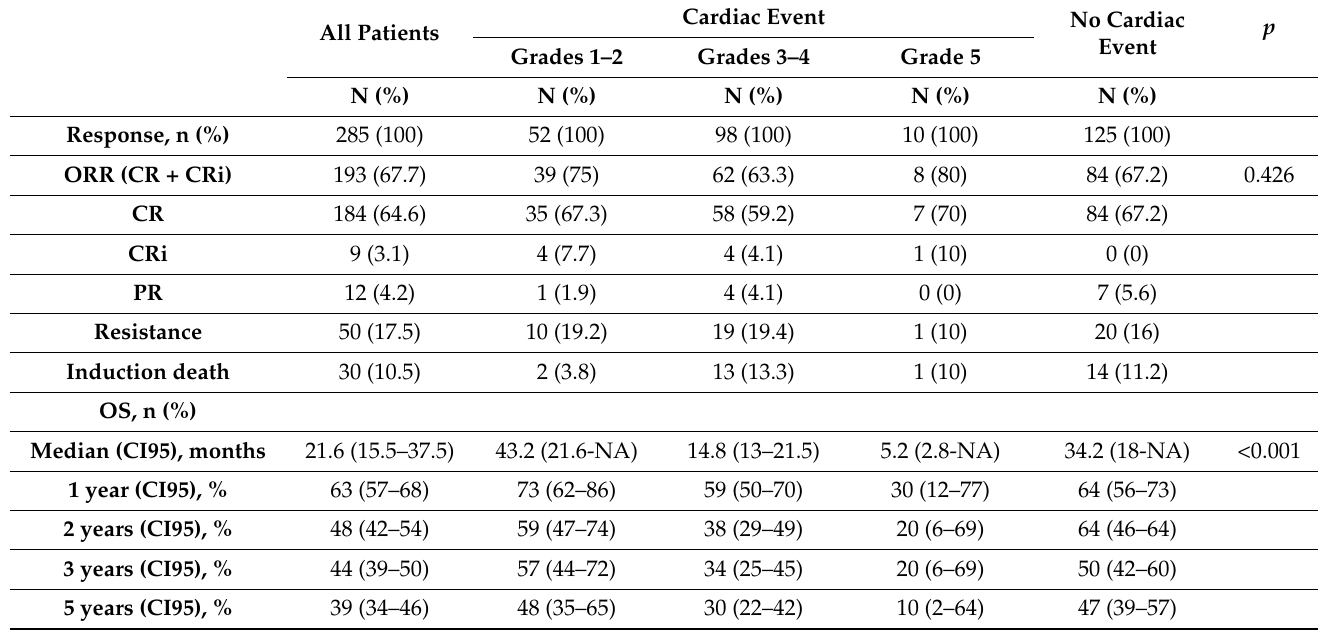
Table 5. Main clinical outcomes (CR/CRi/OS/EFS) in intensive chemotherapy AML patients accord- ing to the occurrence of their first cardiac events (grade 0 vs. 1–2 vs. 3–4 vs. 5) from index date to last